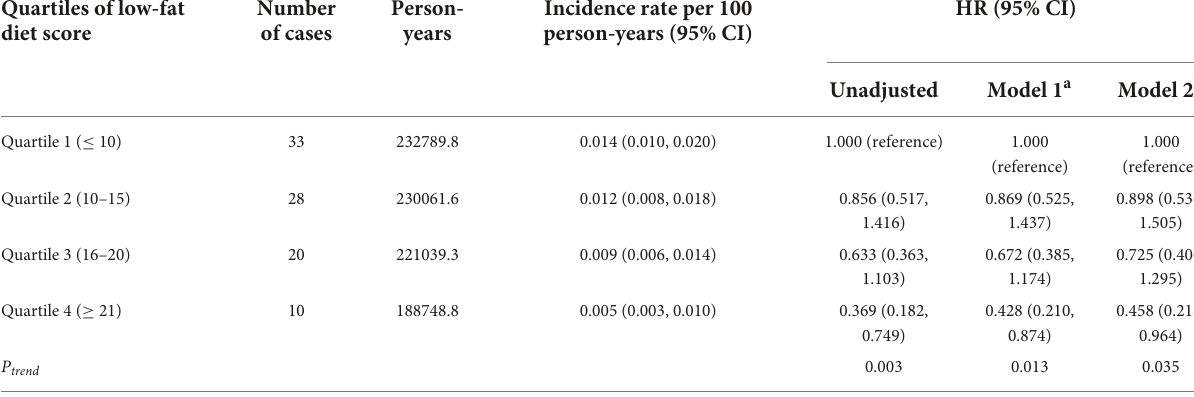
TABLE 2 Hazard ratios of the association of low-fat diet score with the risk of liver cancer. Quartiles of low-fat diet